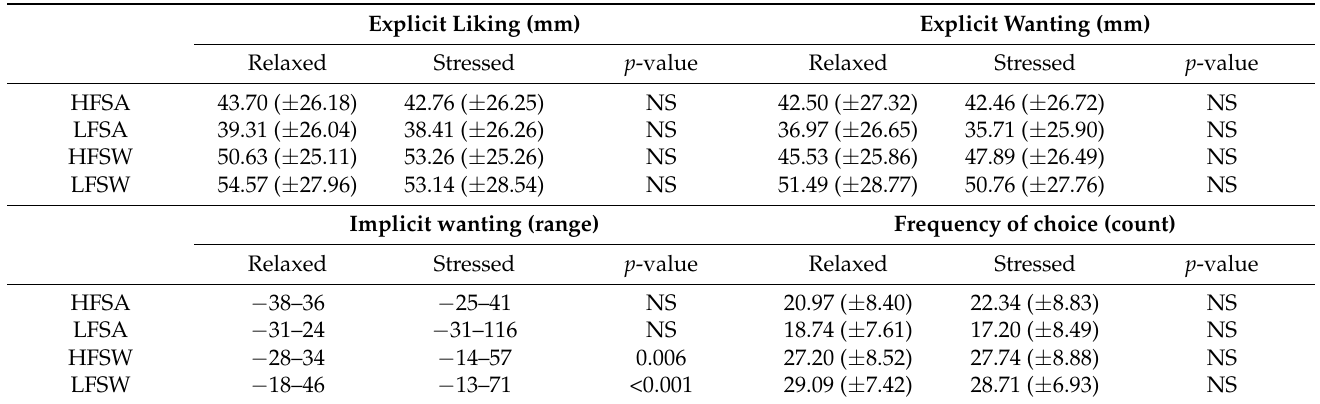
Table 4. Mean ( ± SD) Leeds Food Preference Questionnaire outputs for the different food categories, relaxed and stressed